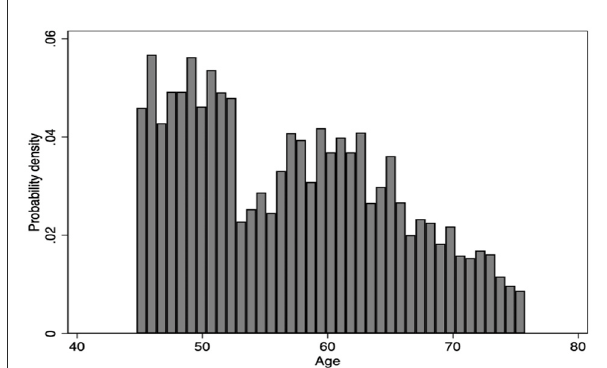
FIGURE3 The probability density around age 60. Source: CFPS2014 and Stata 16.0.